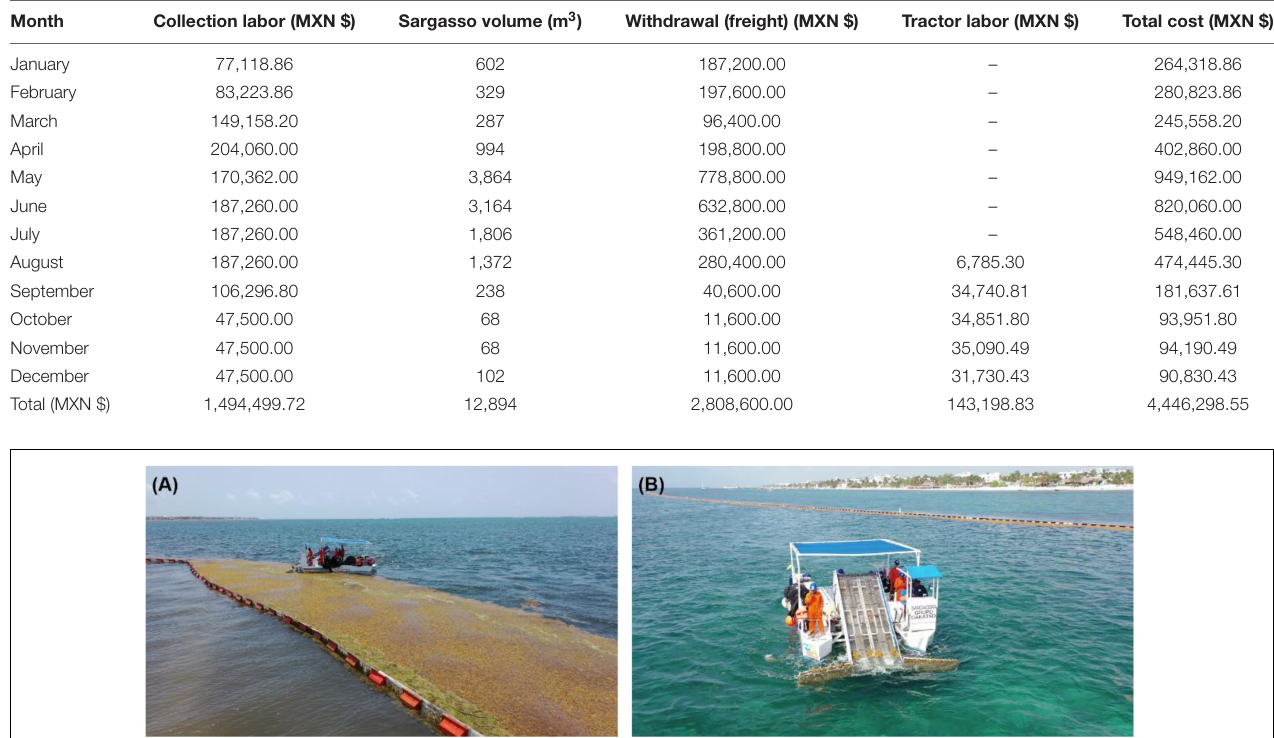
TABLE 2 | Sargasso collection data from a hotel with a 400 m beachfront in Puerto Morelos in 2019.